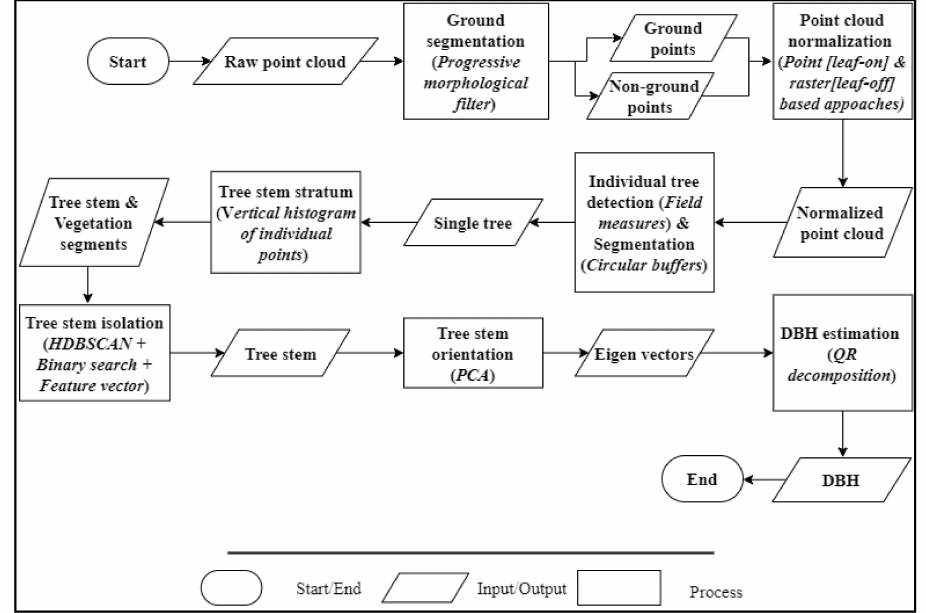
Figure 3. Point cloud processing workflow (ISO 5807) for estimating the Diameter at Breast Height (DBH). HDBSCAN: Hierarchical Density-Based Spatial Clustering of Applications with Noise; PCA: Principal Components Analysis.